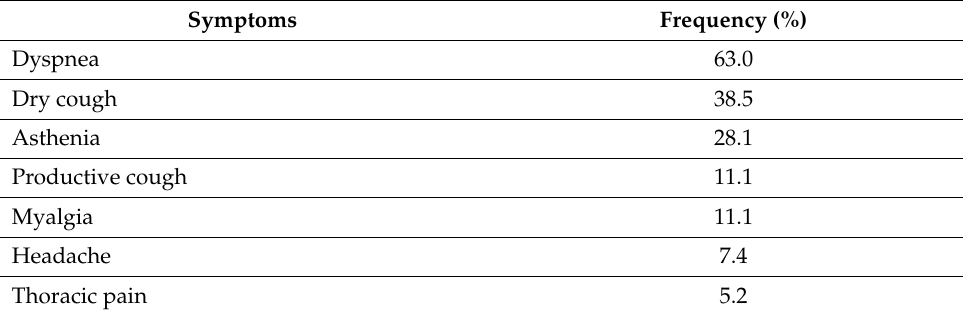
Table 2. Common symptoms upon hospital admission.